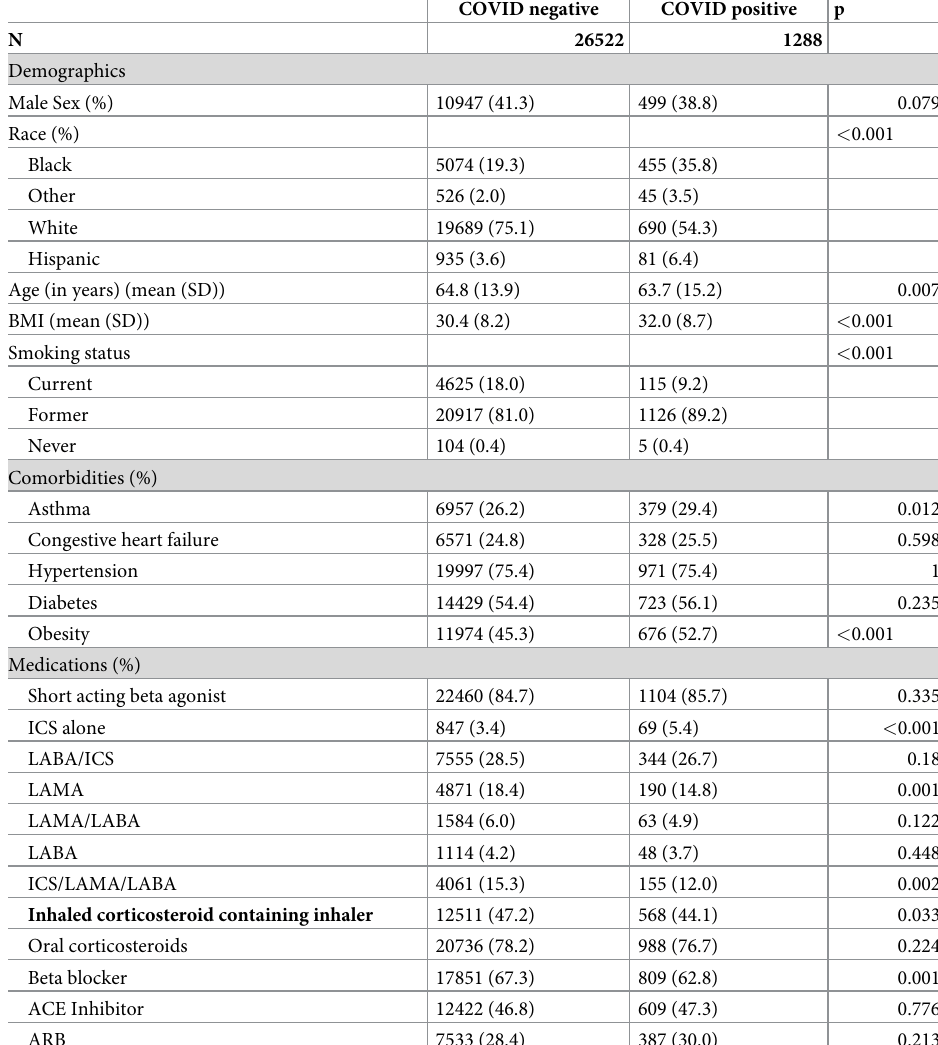
Table 1. Clinical characteristics of patients with COPD tested for COVID-19. COVID negative COVID positive